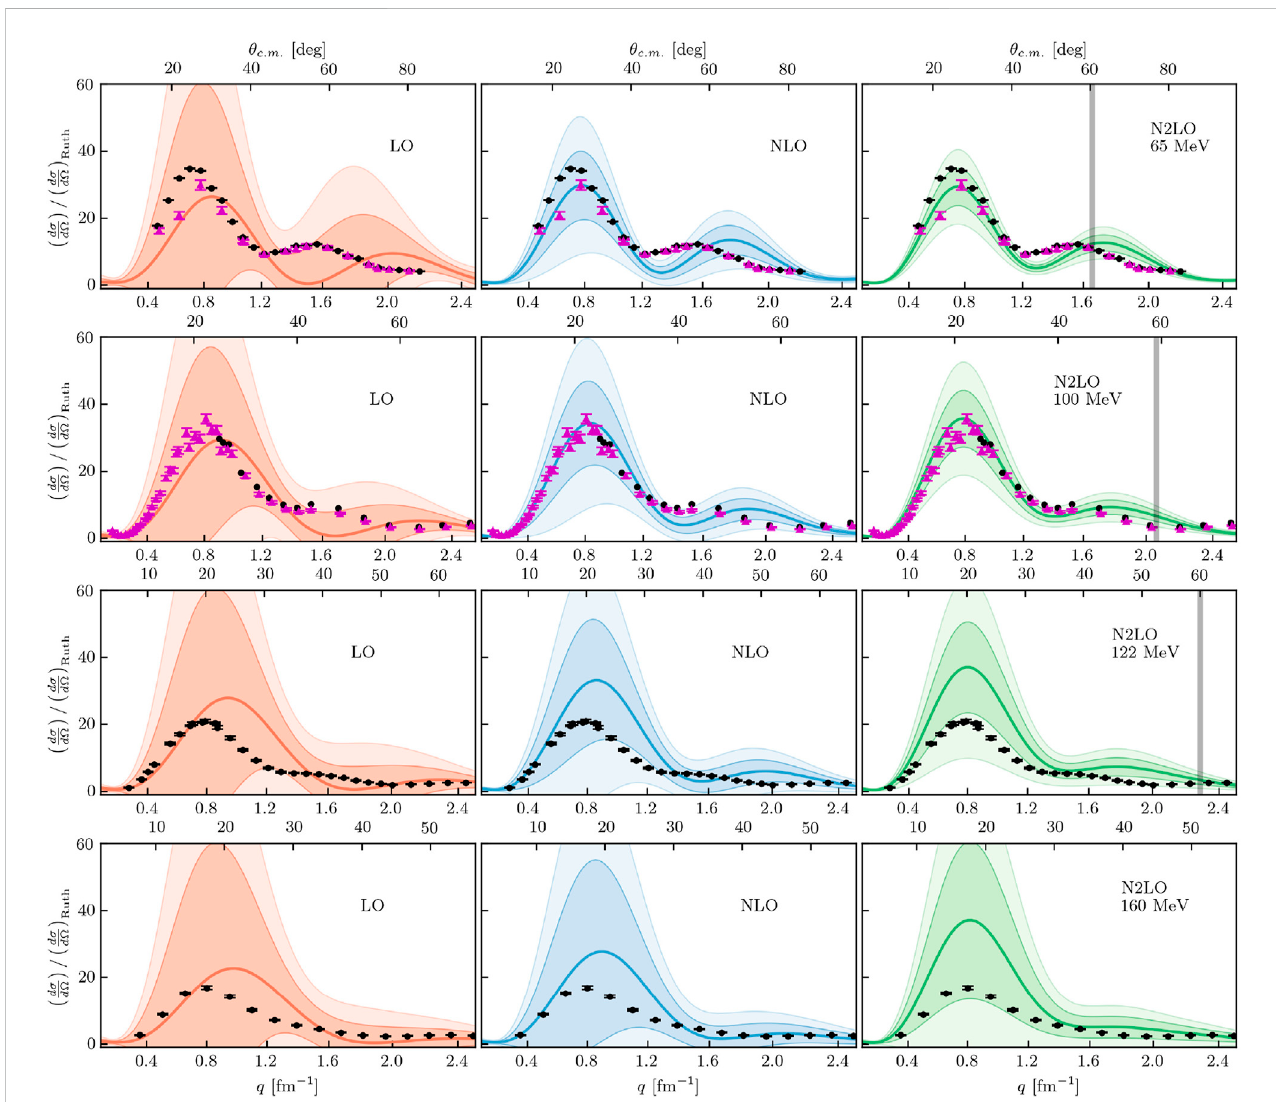
FIGURE 6 DifferentialcrosssectiondividedbyRutherfordforprotonscatteringon 12 Cat( fi rstrow)65 MeV,(secondrow)100 MeV,(thirdrow)122 MeV,and(fourth row) 160 MeV for LO (left column), NLO (middle column), and N2LO (right column) with corresponding 1 σ (darker bands) and 2 σ (lighter bands) error bands. Black dots/purple triangles are experimental data from Ref. [79] (65 MeV, black dots) [80], (65 MeV, purple triangles) [81], (96 MeV, purple triangles) [82], (99 MeV, black dots), and [83] (122 MeV and 160 MeV). Figure from Ref.